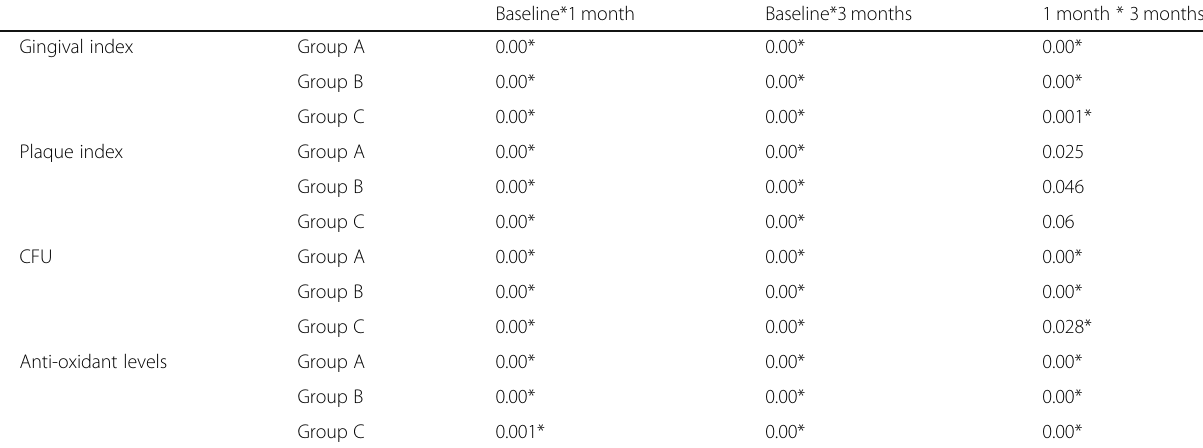
Table 5 Changes in the assessed parameters within the groups at different time intervals using Post hoc Wilcoxon sign rank